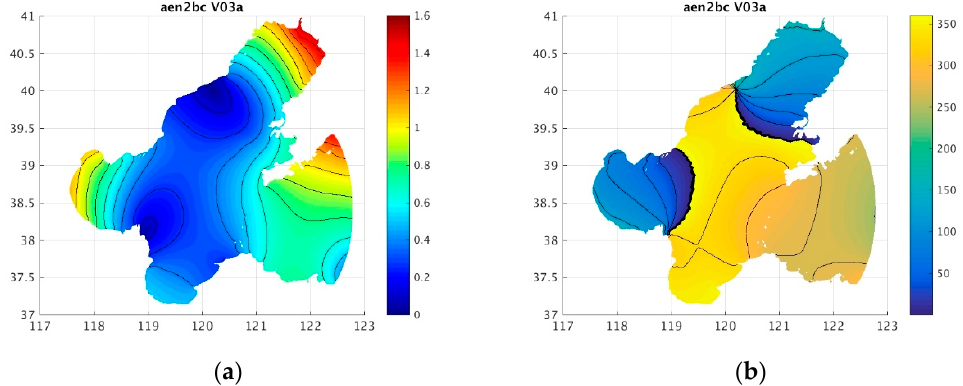
Figure 4. M 2 co-amplitude lines (m) ( a ) and co-phase lines ( o ) ( b ) in Bohai Sea, generated with optimal boundary condition.